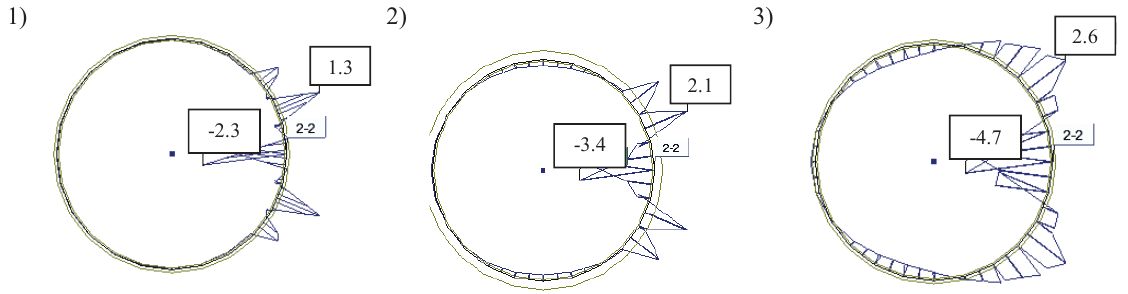
hz , kNm/m ( 5.0/ = c hz ): 1) G =0.25, 2) G =0.4 and 3) G c N